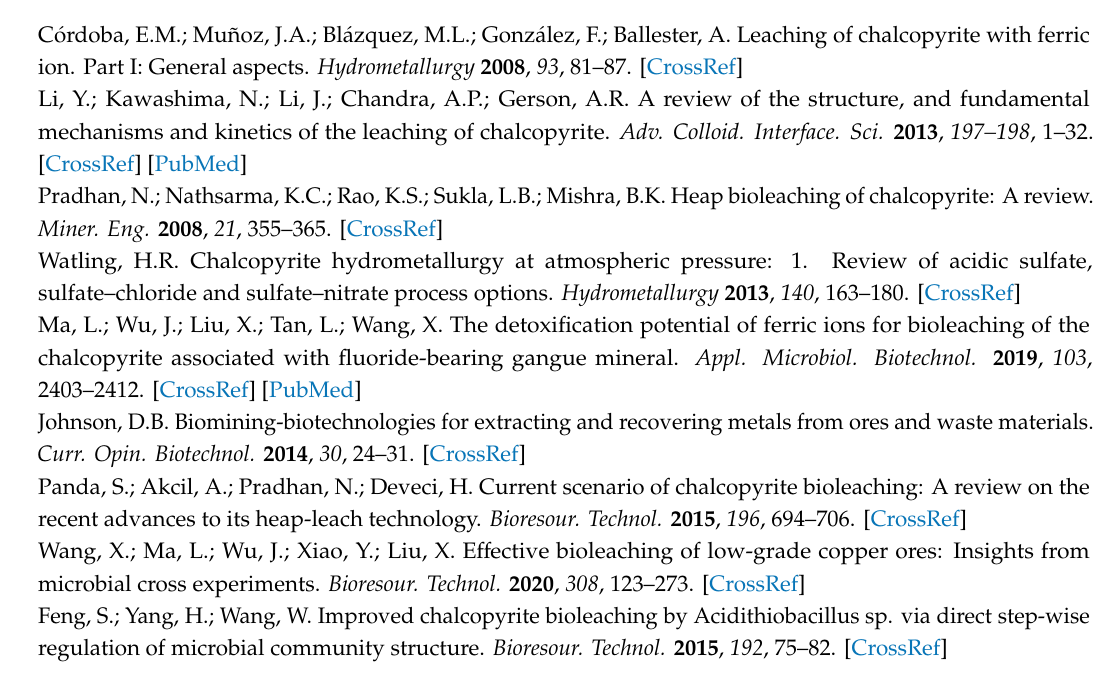
Figure S1: The forward cyclic voltammetry (CV) ( a ) and reverse CV ( b ) of chalcopyrite, Figure S2: The changes in cell adsorption ( a ) and Cu leaching rate ( b ) during the bioleaching of chalcopyrite mechanically activated in di ff erent